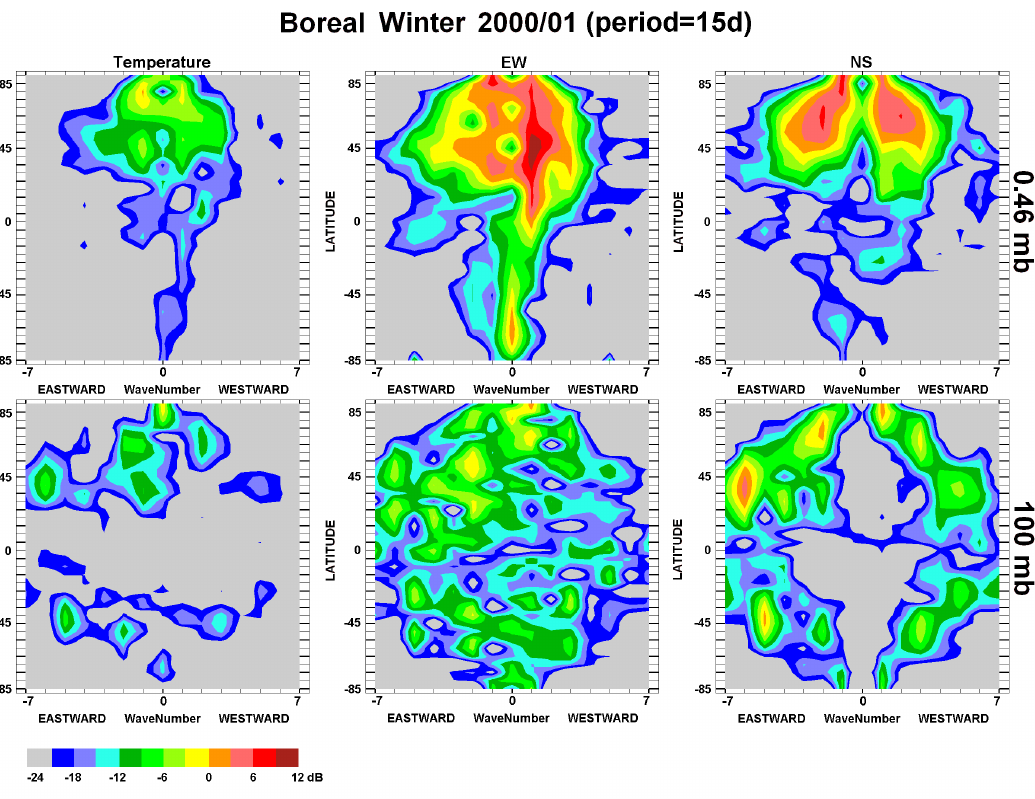
Fig. 9. Plots of wave number versus latitude for the oscillation with the period of 15 days in temperature (left), zonal, EW, (middle) and meridional, NS, (right) wind components at 100mbar (at the bottom) and 0.46mbar (at the top) pressure levels during 2000/01 boreal winter (December 2000 − February